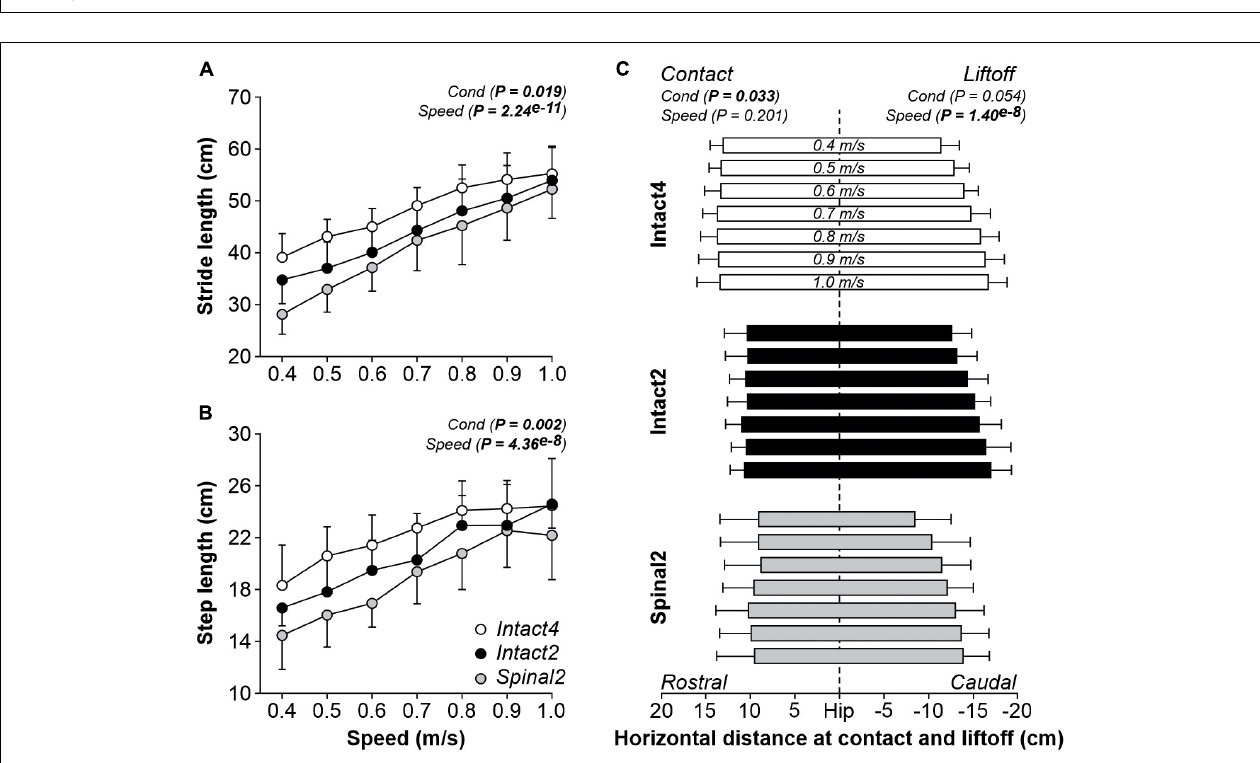
FIGURE 2 | Modulation of spatial parameters during quadrupedal or hindlimb-only locomotion in intact and spinal cats across speeds. Stride length (A) , step length (B) and the horizontal distance at liftoff/contact (C) are shown during Intact4, Intact2 and Spinal2 conditions at seven treadmill speeds. At each speed, we averaged 6–15 cycles per cat. Each data point or bar indicates the mean ± SD for the group ( n = 9 cats). P values comparing conditions (Cond) and speeds are indicated (main effects of repeated-measures ANOVA). Vertical dashed line indicates the zero or hip position.